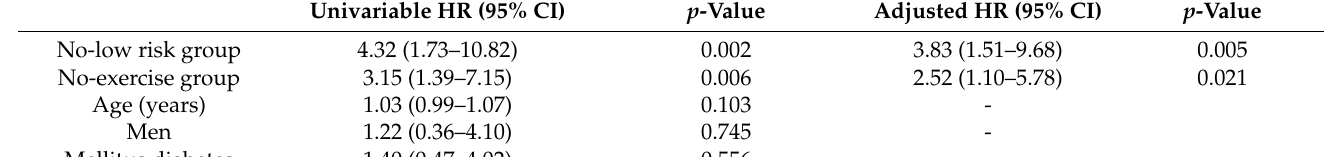
Table 3. Univariable and multivariable Cox regression analyses for cardiac rehospitalization.